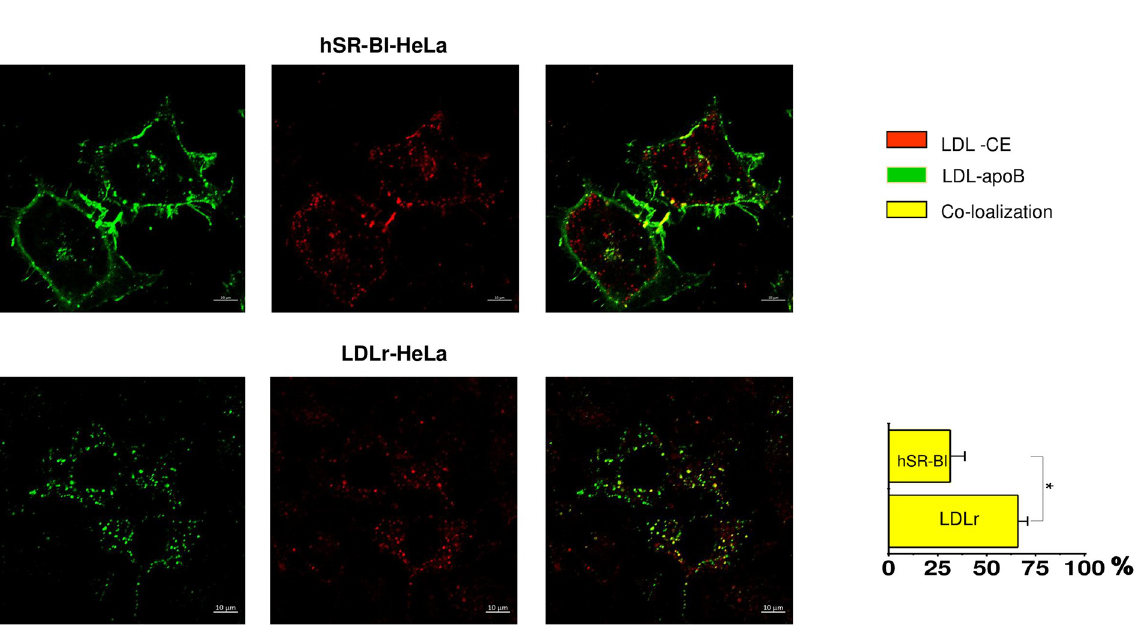
Fig 4. Dual -CE/protein-labeled LDL uptake and sorting. HeLa cells were plated at 30% confluency on glass covered slips and then pre- incubated in serum free media for 24 hours prior to experiments. CE/protein-labeled LDL were added to the media for 1 hour, washed and chased for 30–60 minutes in serum/lipoprotein free media. The data is arranged in rows with a color code seen on the right side of the panels. The bar corresponds to 10 μ m, � p < 0.015, �� p < 0.01.